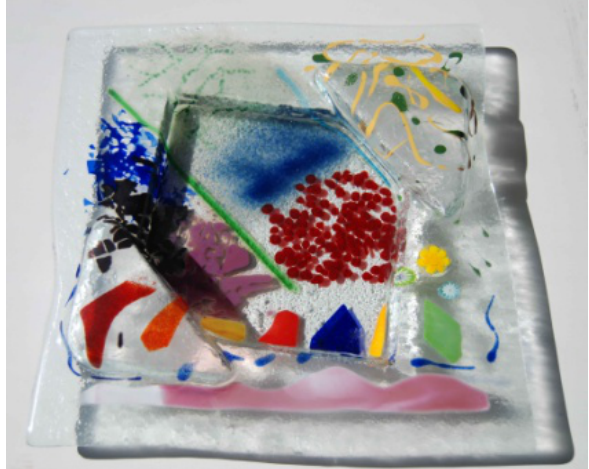
Figure 1. Glass thermoforming and fusing technique to manufacture an ashtray.